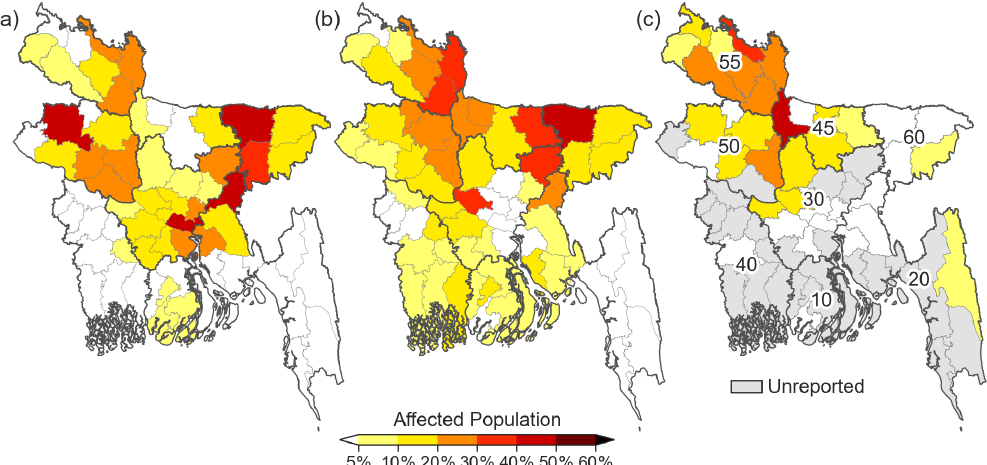
Figure 6. Percentage of affected population from (a) flood forecast, (b) satellite inundation, and (c) post-disaster reports. The division codes are Barisal (10), Chittagong (20), Dhaka (30), Khulna (40), Mymensingh (45), Rajshahi (50), Rangpur (55), and Sylhet (60).